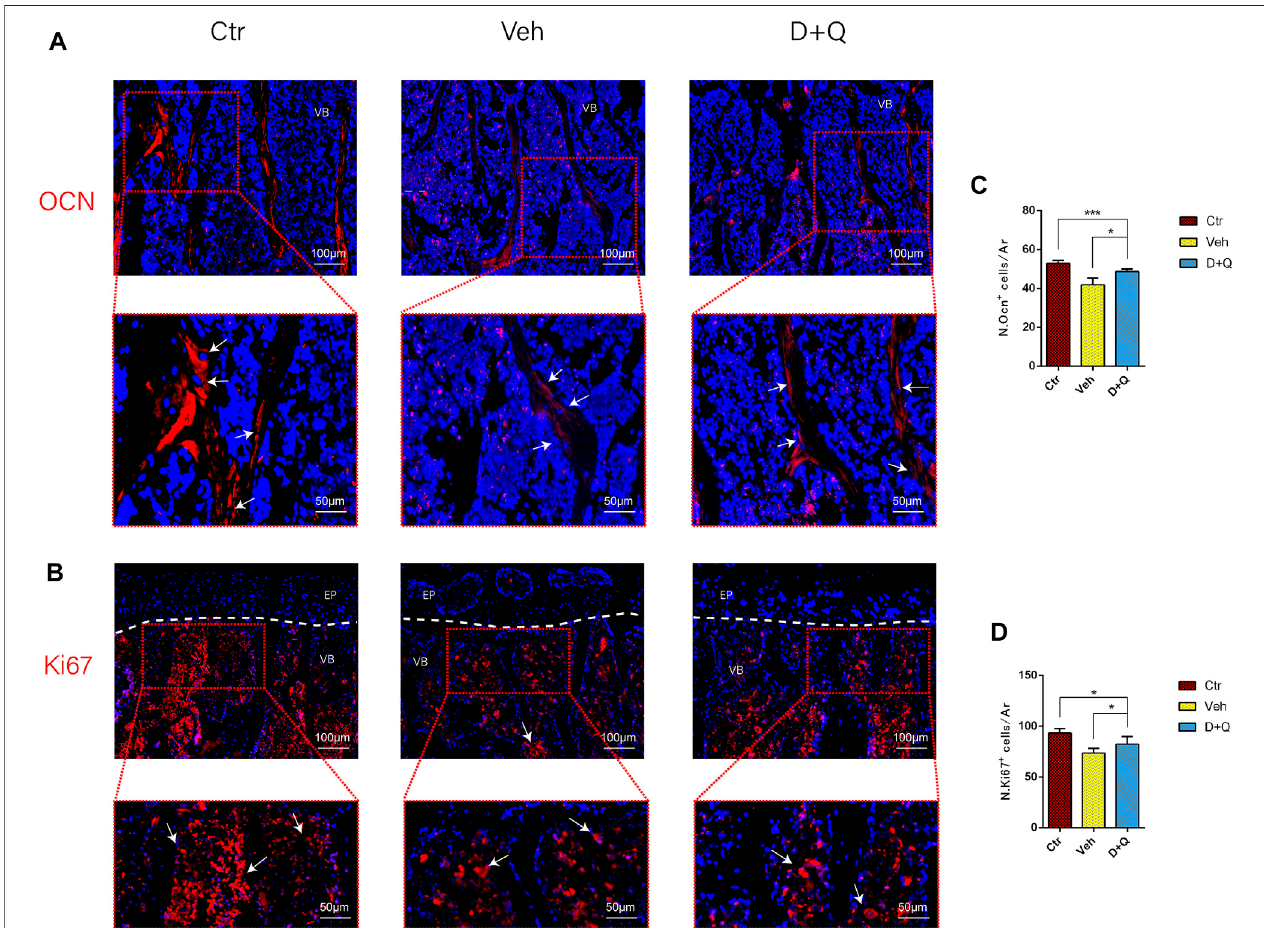
FIGURE5| Qualitativeandquantitativedetectionofosteogenicandproliferativemarkerinthesub-endplateregion.Theexpressionof (A) OCNand (B) Ki67,which could be observed in the sub-endplate region by histological assessment. Cell nuclei were stained with DAPI (blue). (C , D) Quantitation of the number of OCN and Ki67 cellsinthesub-endplateregion.Dataarerepresentedasmean±SD.NP,nucleuspulposus;AF,annulus fi brosus;EP,endplate;Ctr,controlgroup;Veh,vehiclegroup;D +Q,dasatinibandquercetingroup.Scalebar=100 μ m(upper),50 μ m(lower);D+Qvs.CtrgroupandVehgroup;ns,nosigni fi cance;* p < 0.05;** p < 0.01;*** p < 0.001; **** p <